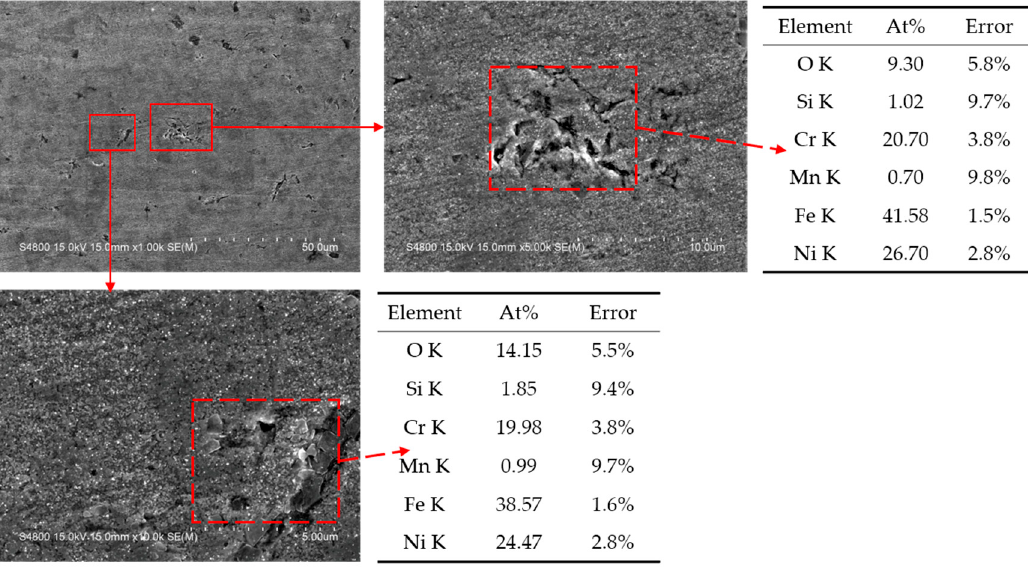
Figure 12. SEM images and the corresponding composition analysis of the passive film formed on In800 with the zinc treatment.